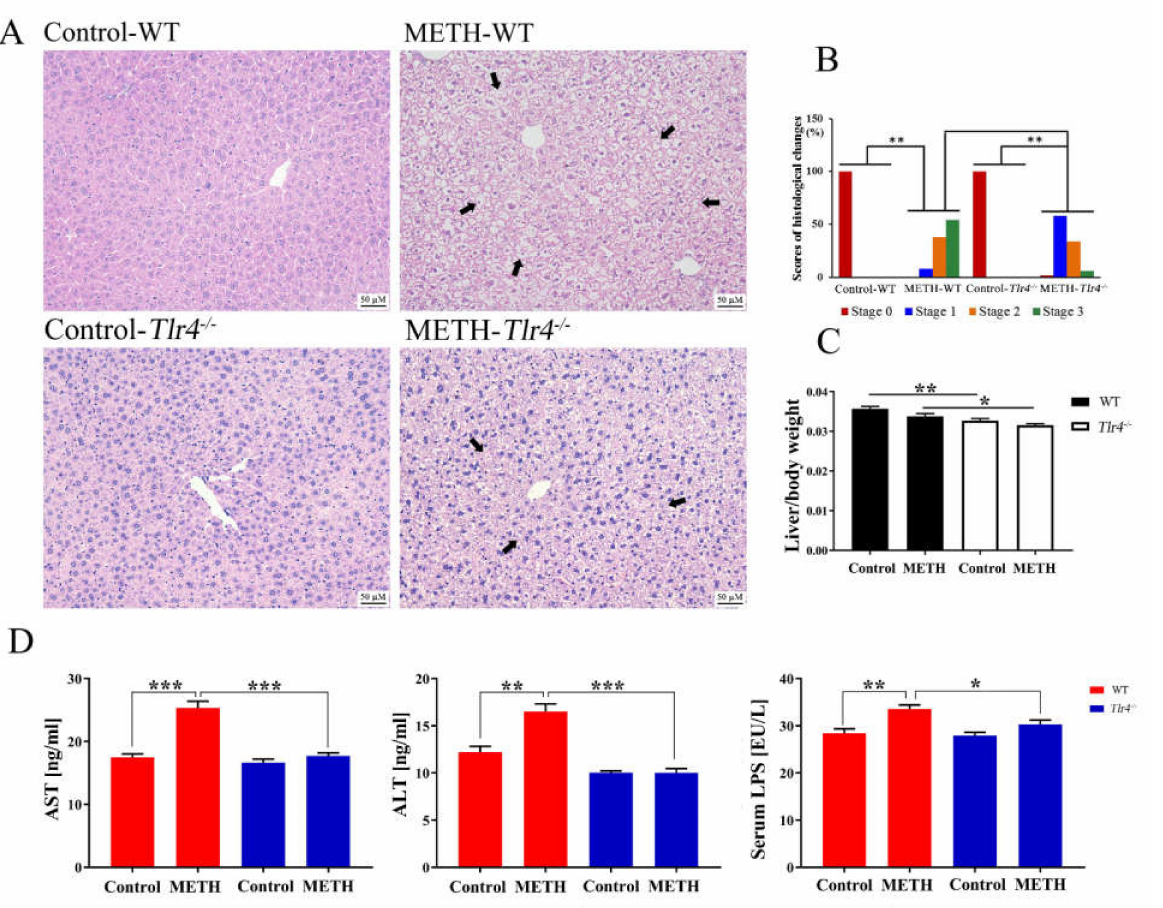
Figure 4. Silencing the Tlr4 gene in mice significantly ameliorated METH-induced hepatic injury. ( A ) METH-induced histopathological changes (shrunken nucleus, loose cytoplasm, and extensive vacuolar degeneration; arrows) were remarkably weakened in Tlr4 − / − mice. Bar = 50 µ M. ( B ) The scores of histological changes; ( C ) The relative liver weights of the wild-type (WT) and Tlr4 − / − mice; ( D ) Differences in serum AST, ALT, and LPS levels between the wild-type and Tlr4 − / − mice. * p < 0.05, ** p < 0.01, *** p <